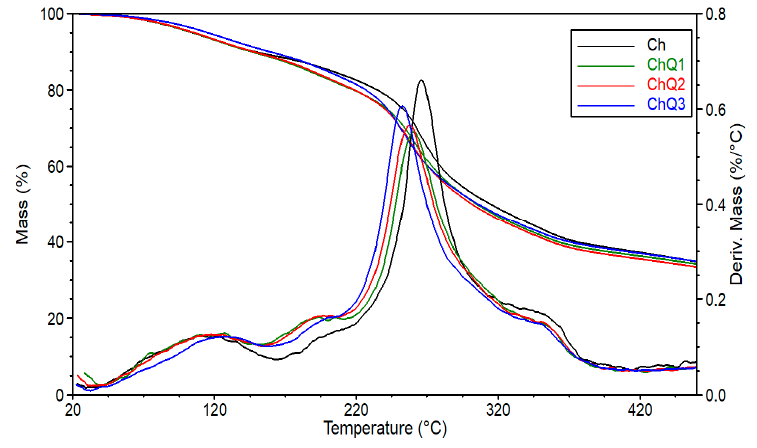
Figure 8. TG and DTG curves of unmodified (Ch) and modified chitosan (ChQ).